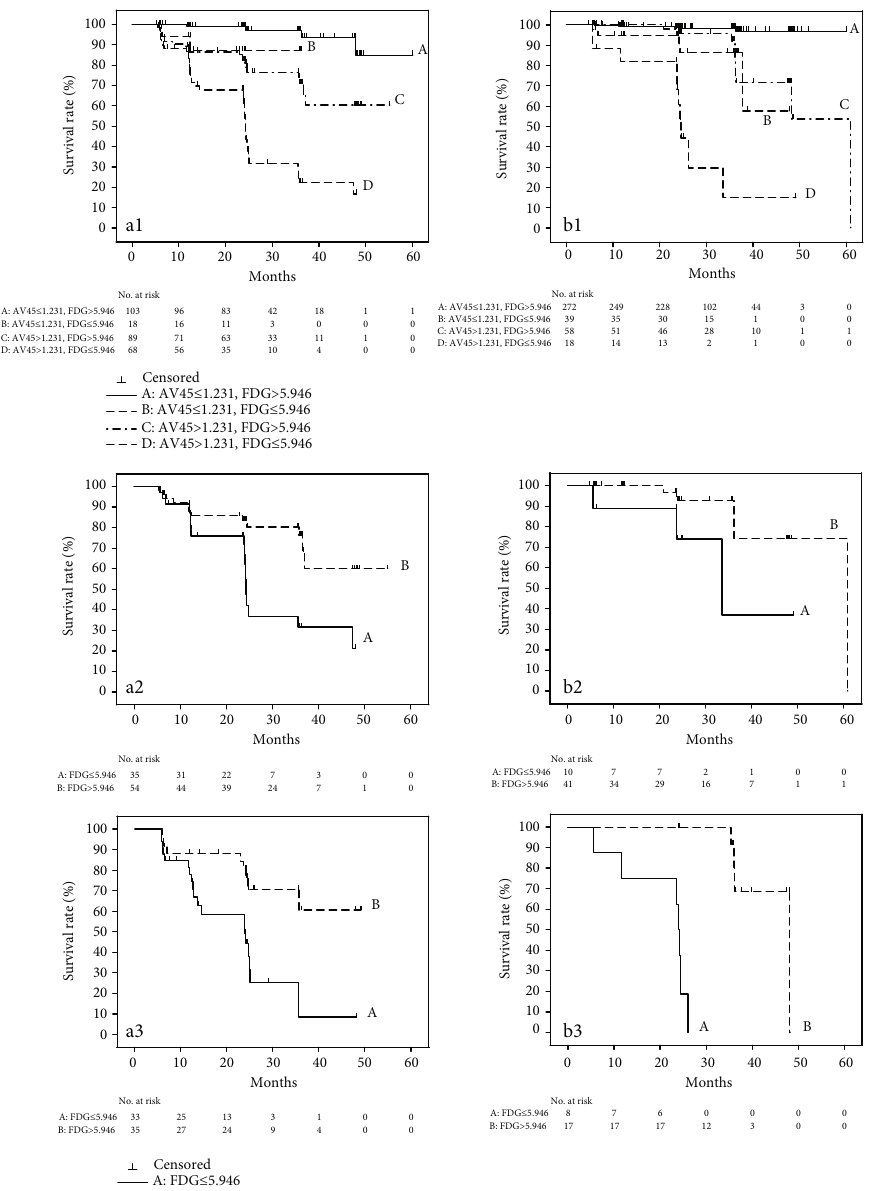
Figure 2: Risk classi fi cation by the combination of FDG with brain PET Abeta. (a) Survival curves by combination of Abeta and FDG in ApoE4 carriers. (a1, A) Abeta ≤ 1 : 231 and FDG > 5 : 946 ; (B) Abeta ≤ 1 : 231 and FDG ≤ 5 : 946 ; (C) Abeta > 1 : 231 and FDG > 5 : 946 ; and (D) Abeta > 1 : 231 and FDG ≤ 5 : 946 . (a2, A) 1 : 231 < Abeta ≤ 1 : 462 and FDG ≤ 5 : 946 and (B) 1 : 231 < Abeta ≤ 1 : 462 and FDG > 5 : 946